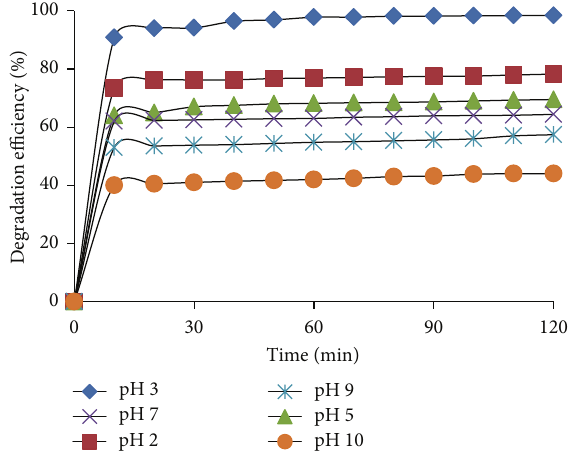
Figure 2: Effect of pH on the discoloration efficiency for Fenton- like oxidation process, ([Fe 3+ ] = 1.0 × 10 −4 M, [H 2 O 2 ] = 5.0 × 10 −2 M, [MAG] = 3.0 × 10 −5 M).